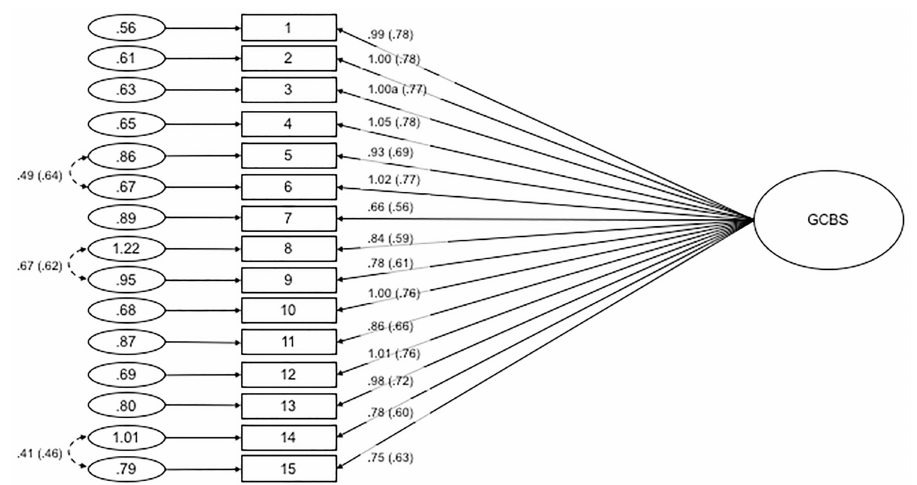
Fig 3. Path diagram and estimatesfor the one-factor Generic Conspiracist Beliefs Scale. Item numbers in the figure reflect the item number in Table 6. Item numbers in the figure reflect the item numberin Table 6. The large circle is the latent construct, with the rectanglesrepresentingmeasuredvariables, and the small circles with numbersare the residualvariables(variances). The factor loadingsare standardised in parenthesises, and the unstandarised values outside, with both being reportedfollowingthe guidelinesof Kline (2011). Significance levels were determined by critical ratios (all p < .001). The factor loadingswere fixed at the indicatedvalue (1.00a).